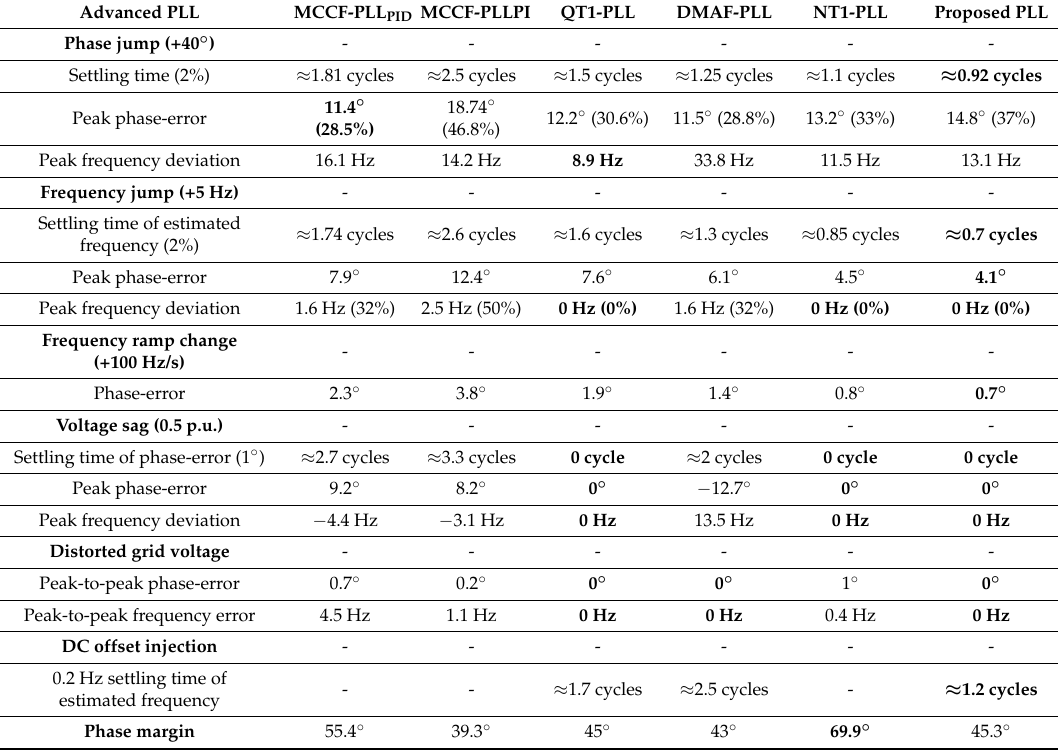
Table 5. Summary of